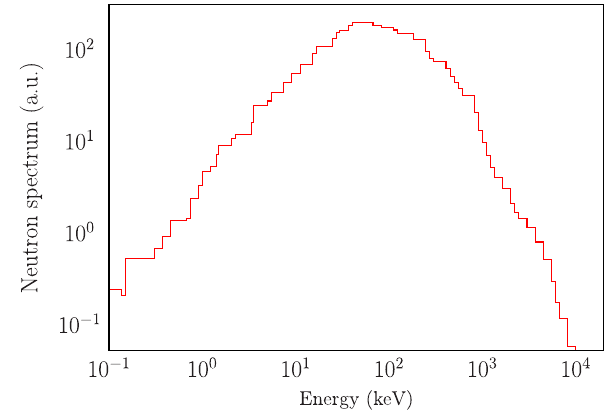
Fig. 3. Neutron spectrum of the imf7 ICSBEP benchmark calculated by MCNP6 using TENDL-2014 nuclear data. This spectrum is averaged for the whole benchmark. In the 238 U blanket, the average neutron energy is 345 keV, while in the 235 U core, it is